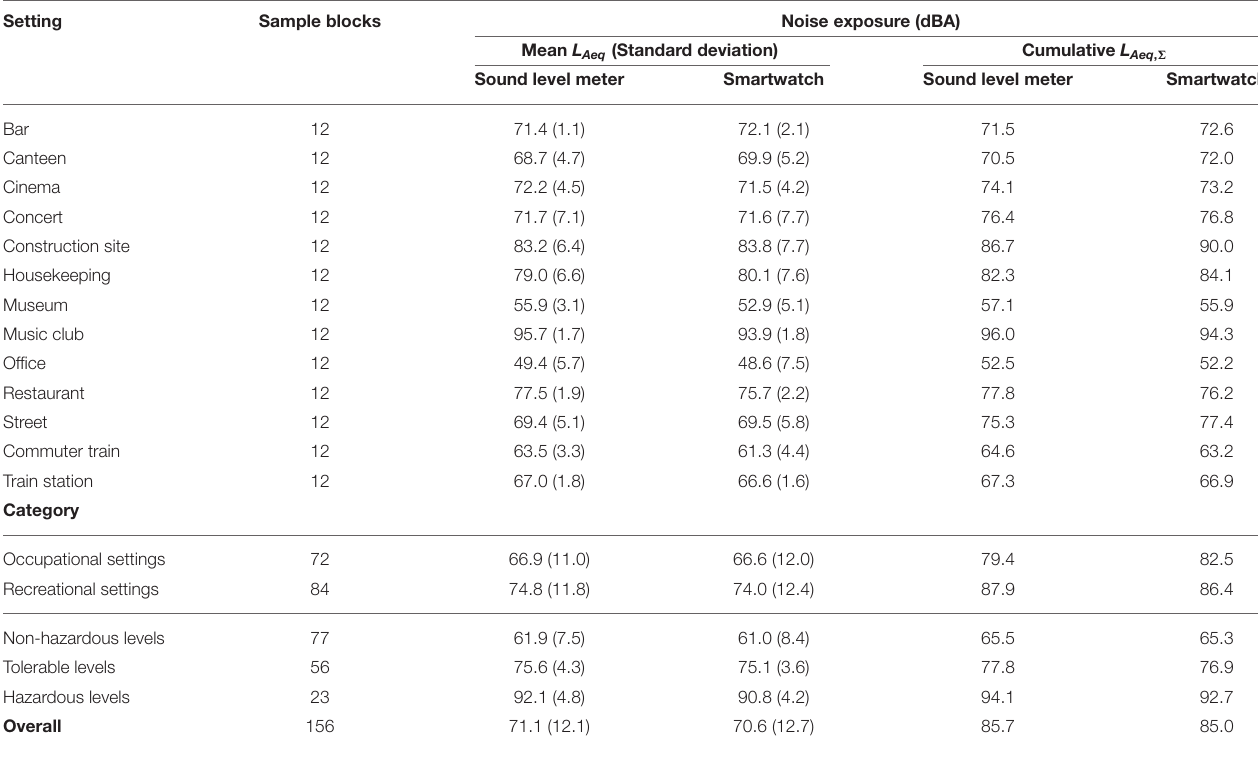
TABLE 2 | Summary of noise exposure for the measured settings and